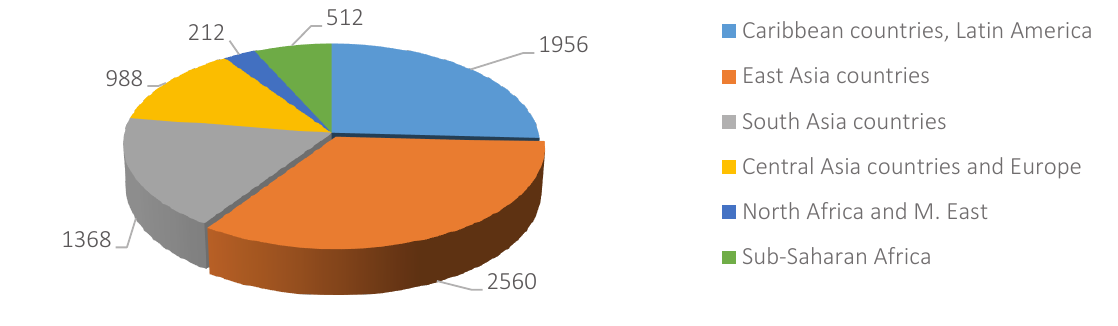
Figure 3. Regions ranked by investment (1991–2019).